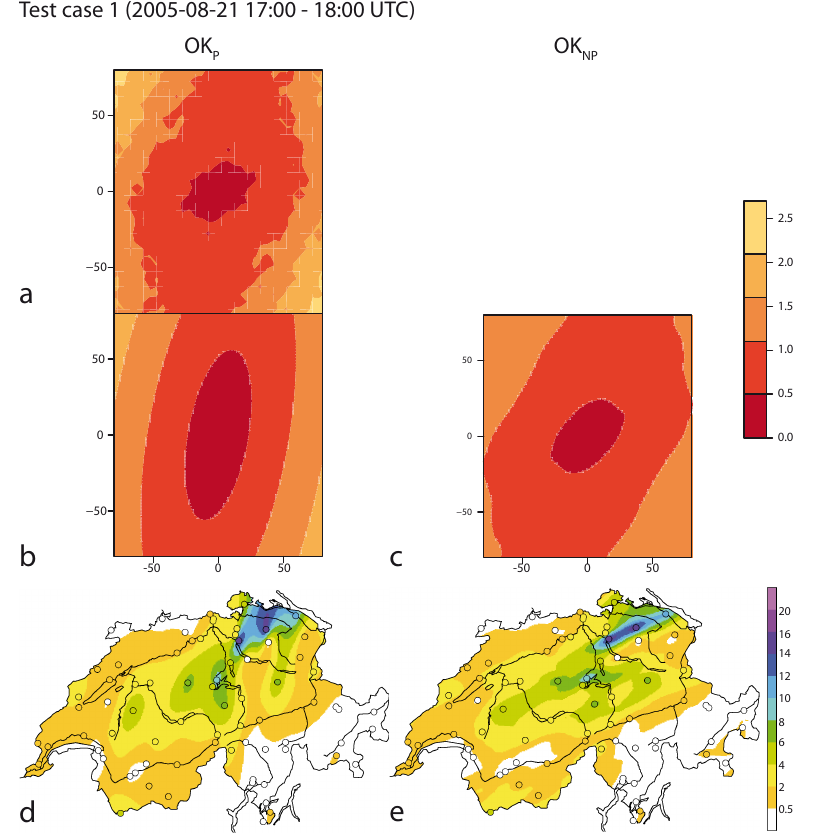
Fig. 6. Ordinary Kriging for test case 1 with a parametric semivariogram (OK p ) and a nonparametric correlogram (OK np ). (a) Empirical semivariogram from subsampled radar field ( mm 2 ), (b) exponential anisotropic semivariogram fit (mm 2 ), (c) nonparametric correlogram from complete radar field (expressed as a semivariance, mm 2 ), (d) OK p prediction, (e) OK np prediction ( mm ).